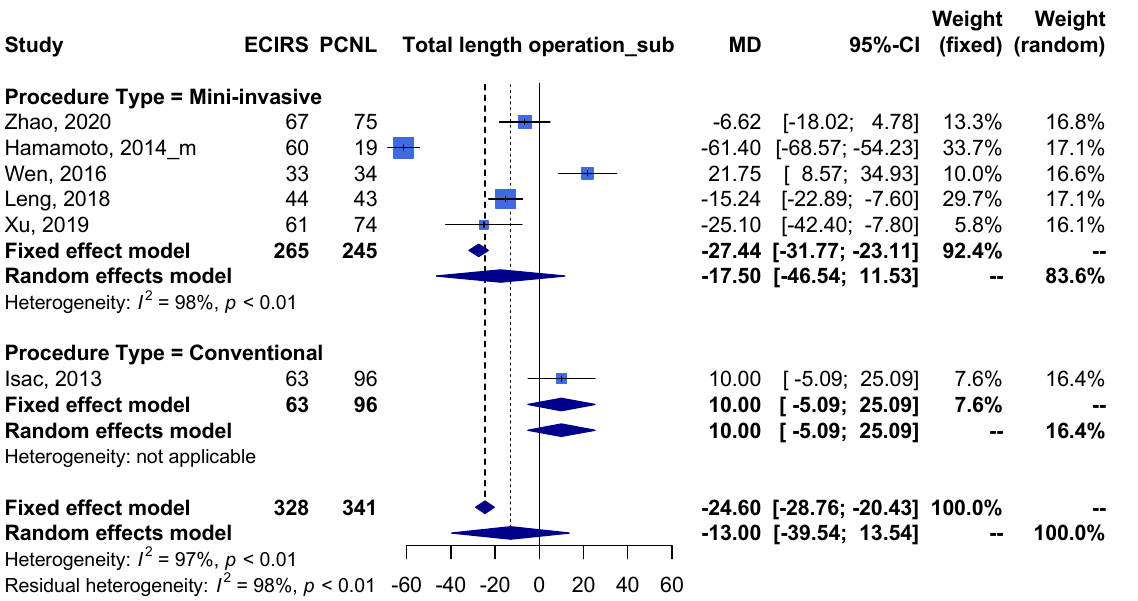
Figure A8. Subgroup analysis of outcome regarding operative time (Mini: [17–19,22,23]; Conven- tional: [21]).